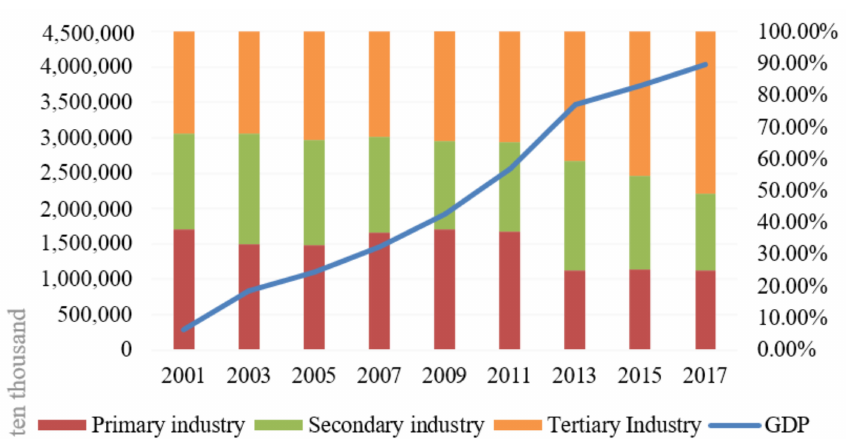
Figure 2. GDP and industrial structure change of Zhangye city from 2001 to